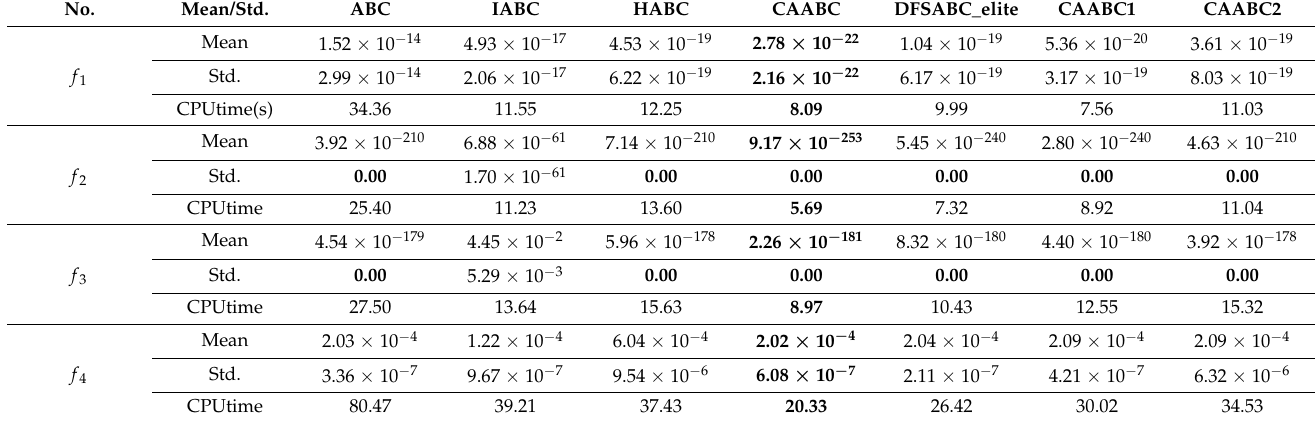
Table 4. Comparison with other improved Artificial Bee Colony in